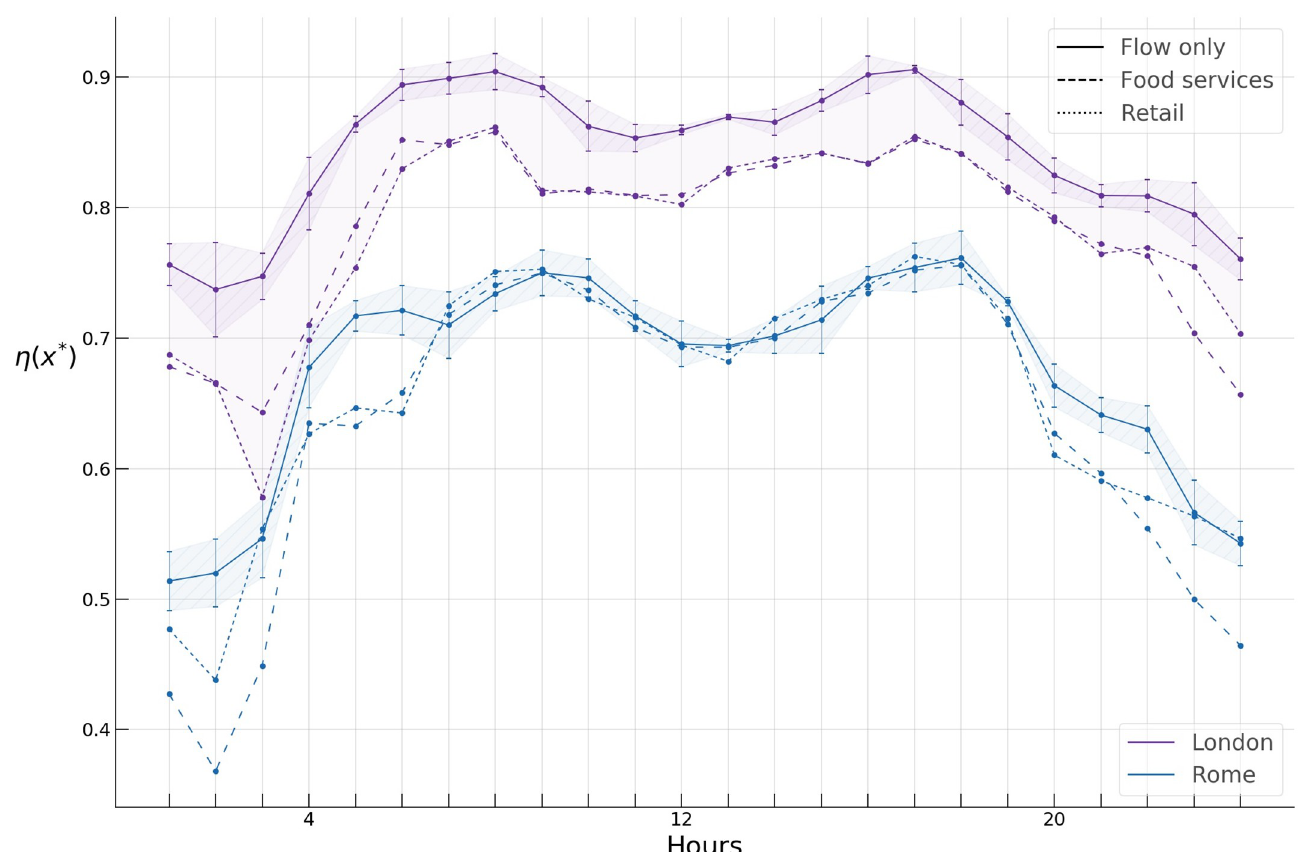
Fig 16. TSI for flow only, food services, and retail activity in Rome and London during a typical day.